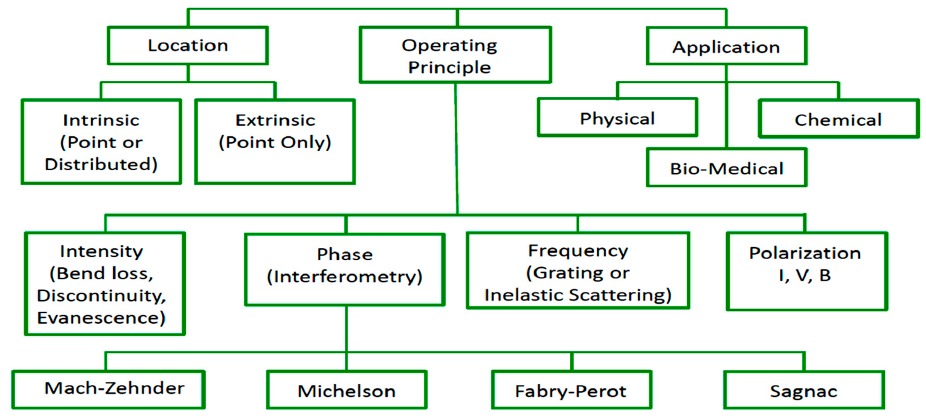
Figure 2. Classification of fiber optic sensors.